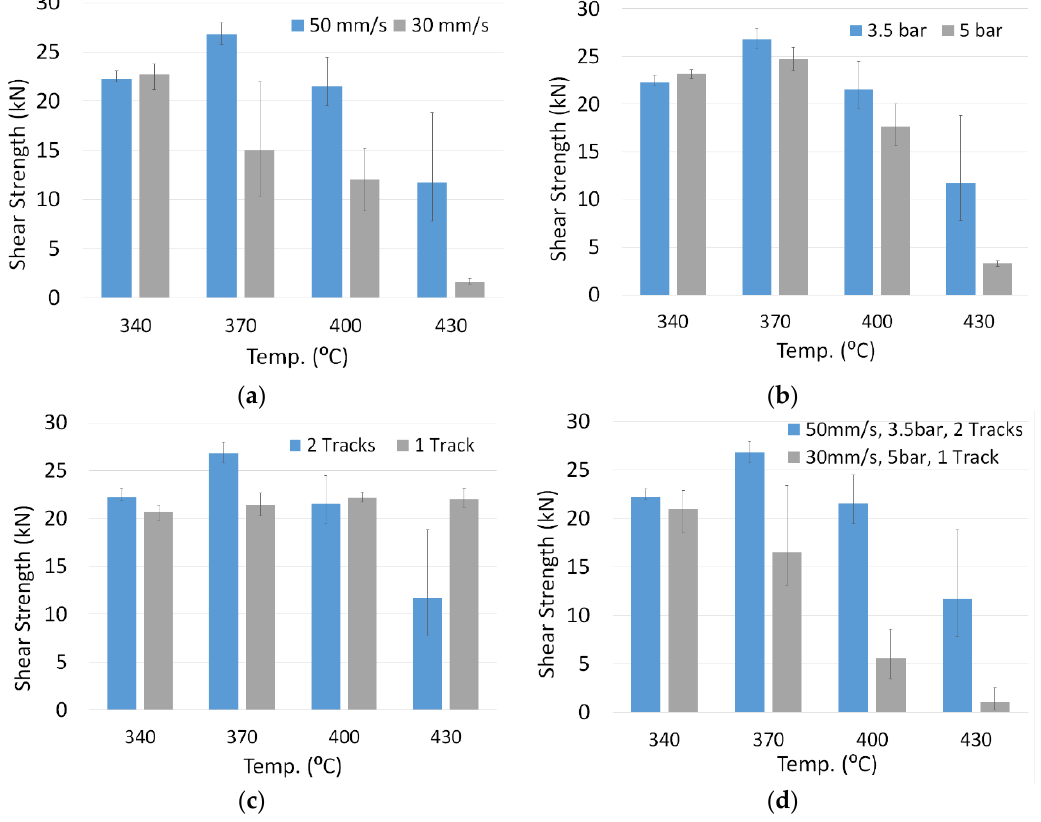
Figure 12. Joining parameter influence on lap shear strength: ( a ) feed rate; ( b ) closing pressure; ( c ) overlapped tracks; ( d ) energy input.